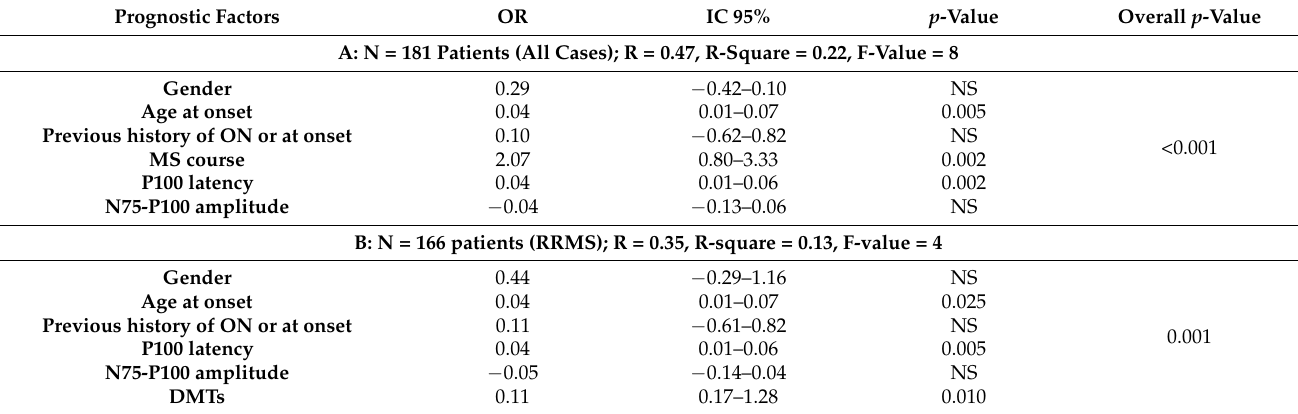
Table 2. Multivariate analysis of clinical–demographic factors, evaluated at diagnosis, and disability over time, according to multiple sclerosis severity score.